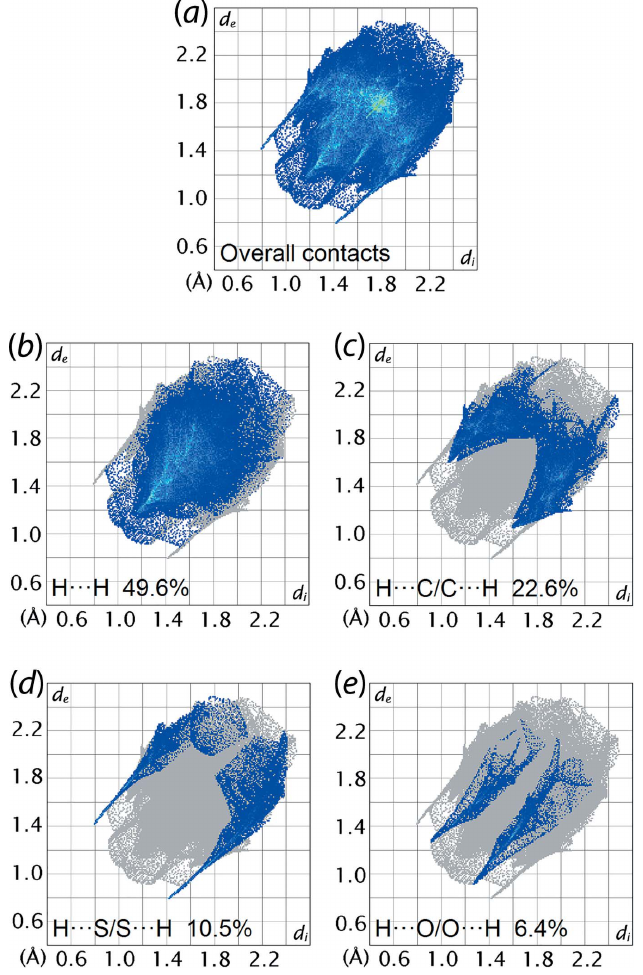
Figure 7 ( a ) A comparison of the full two-dimensional fingerprint plot for (I) and those delineated into ( b ) H (cid:4)(cid:4)(cid:4) H, ( c ) H (cid:4)(cid:4)(cid:4) C/C (cid:4)(cid:4)(cid:4) H, ( d ) H (cid:4)(cid:4)(cid:4) S/S (cid:4)(cid:4)(cid:4) H and ( e ) H (cid:4)(cid:4)(cid:4) O/O (cid:4)(cid:4)(cid:4) H contacts.